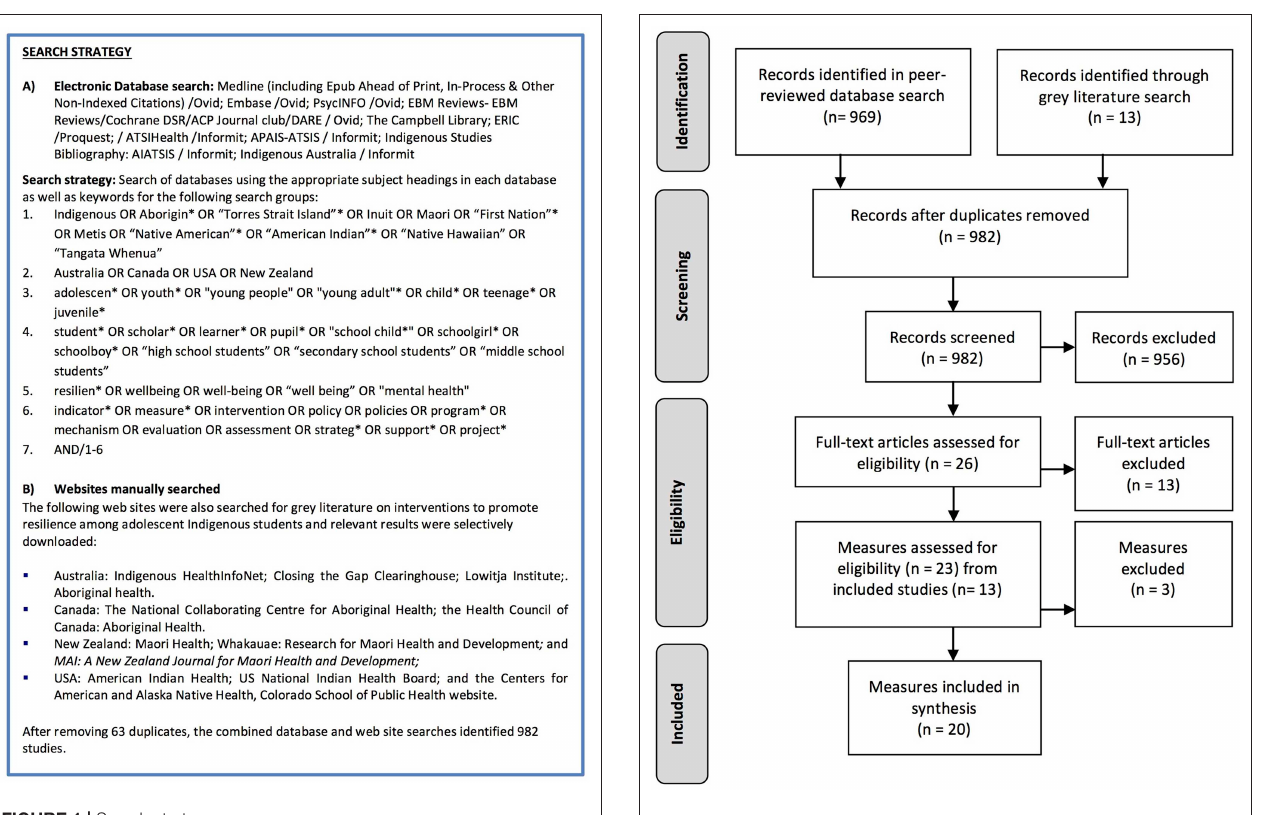
FIGURE 1 | Search strategy. FIGURE 2 | PRISMA flow